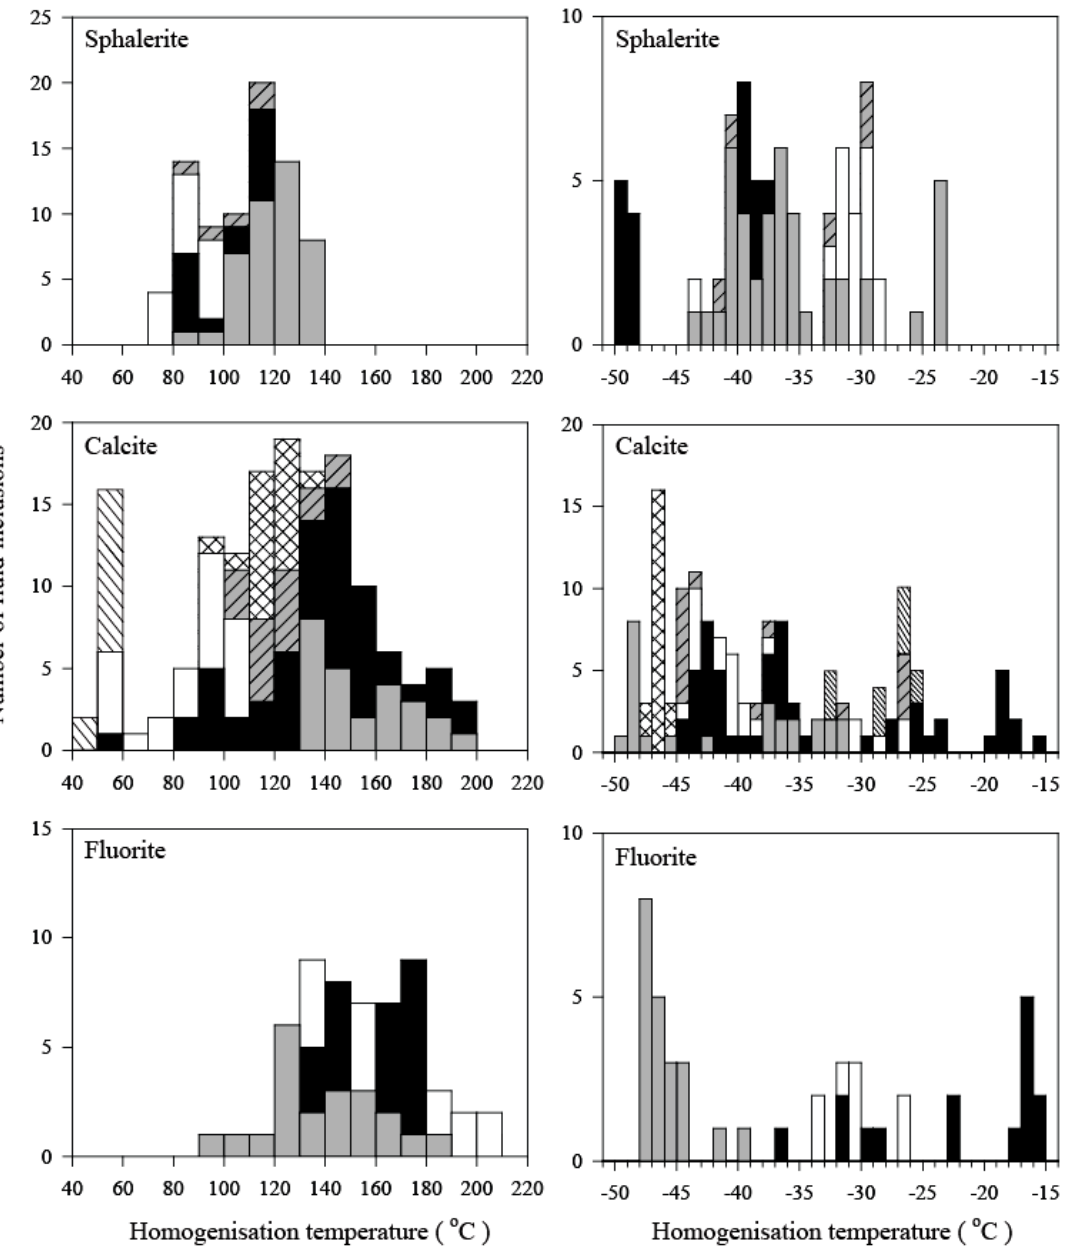
Figure 11. Frequency histograms of homogenisation and final ice melting temperatures for aqueous fluid inclusions in sphalerite, calcite and fluorite from different Zn-Pb mineralised